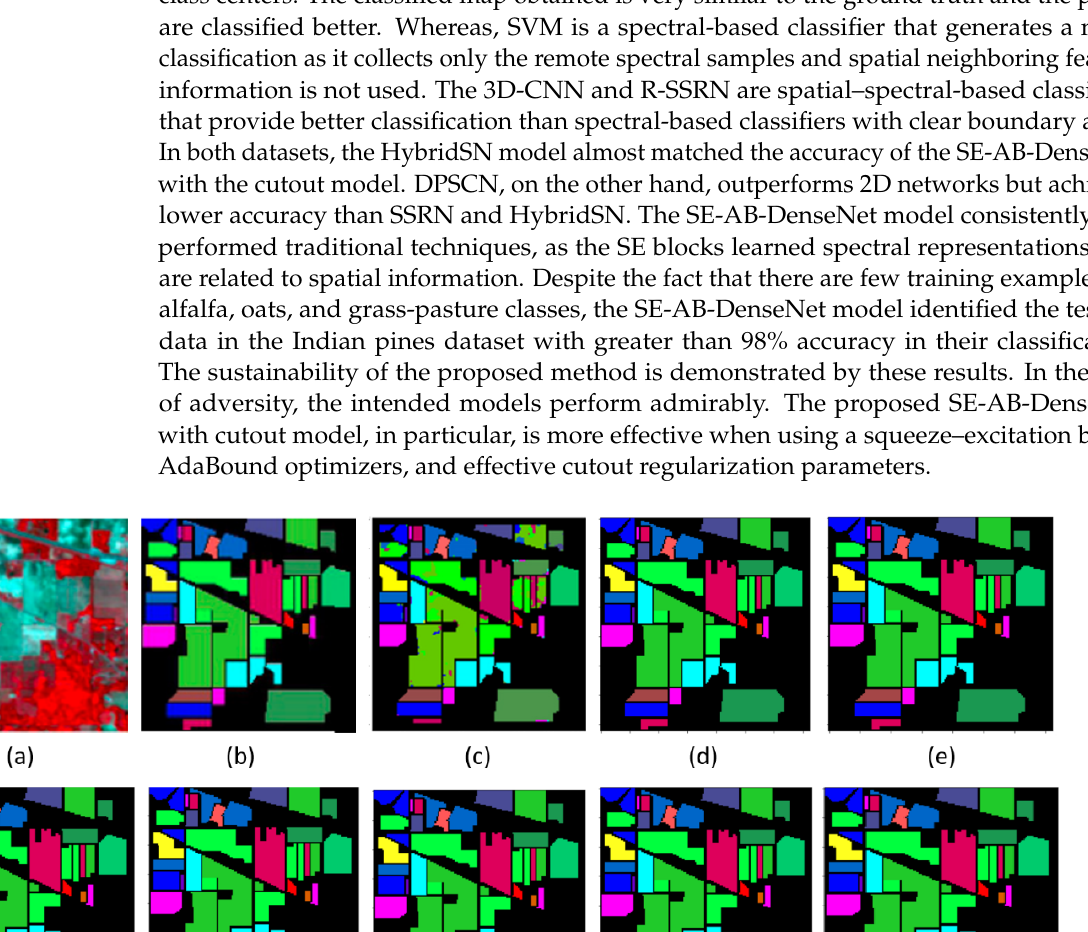
Figure 9. Salinas classification maps: ( a ) RGB (bands 57, 19, and 9) image; ( b ) ground truth; ( c ) SVM; ( d ) 2-D CNN; ( e ) 3-DCNN; ( f ) SSRN; ( g ) HybridSN; ( h ) DPSCN; ( i ) SE-DenseNet with cutout; and ( j ) SE-AB-DenseNet with cutout. For two key reasons, the SE-AB-DenseNet with cutout obtained improved classifica- tion performance with a smaller number of trainable samples. First, when the number of training samples is restricted, a model with a large number of trainable parameters tends to overfit. Second, the SE-AB-DenseNet with cutout is designed automatically using the